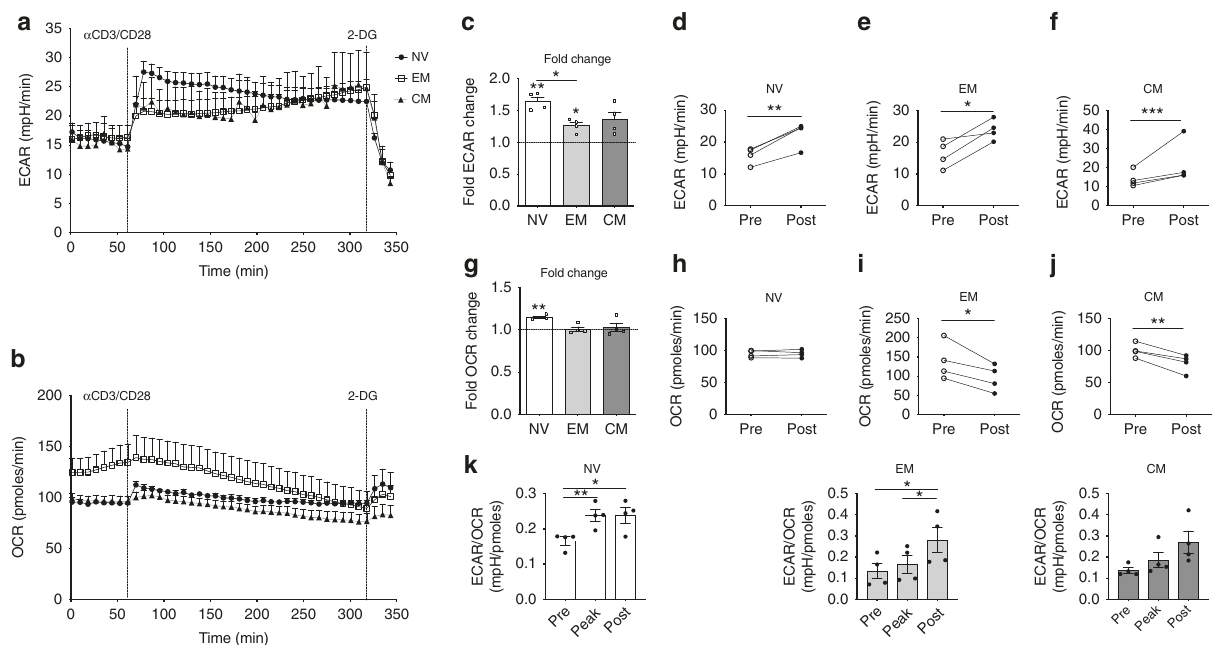
Fig. 3 NV T-cells have a greater metabolic response upon activation. a ECAR and b OCR in NV, EM and CM T- cells upon stimulation with anti-CD3/CD28. c Fold ECAR change in NV, EM and CM T-cells upon activation. d NV, e EM and f CM ECAR ‘ Pre ’ and ‘ Post ’ activation taken from the measurements in the indicated boxes in Supplementary Fig. 3a. g Fold change in OCR in NV, EM and CM T-cells upon activation. h NV, i EM and j CM OCR ‘ Pre ’ and ‘ Post ’ activation taken from the measurements in the indicated boxes in Supplementary Fig. 3a. k ECAR/OCR ratio of ‘ Pre ’ , ‘ Peak ’ and ‘ Post ’ activation kinetics of NV, EM and CM T-cells. Statistical analysis was performed using a non-matching one-way ANOVA with Tukey ’ s multiple comparison test ( c , g , k ). For non-parametric data, a Kruskal − Wallis test with Dunn ’ s multiple comparisons test was used. A one-sample t -test was also used comparing values to a theoretical value of 1 ( c , g ). A paired t -test was also used ( d – f , h – j ) whereby a Wilcoxon matched-pairs signed rank test was applied to non-parametric data. Data are representative of four experiments ( a – k ) and are expressed as mean ± SEM; * p ≤ 0.05, ** p ≤ 0.01, *** p ≤